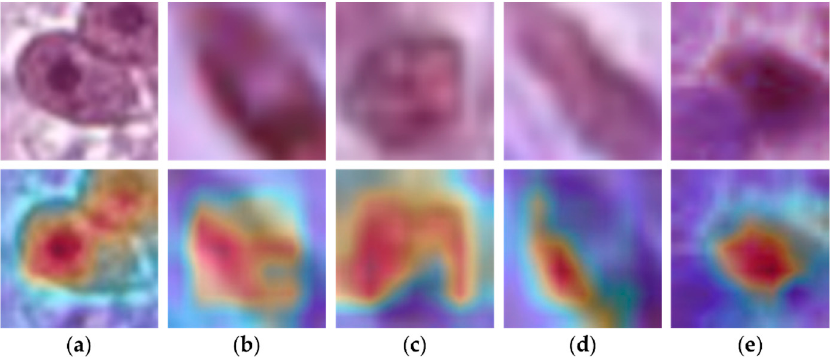
Figure 9. Different types of cell instances in PanNuke (the first row) with their classification saliency maps (the second row). ( a ) neoplastic cell, ( b ) epithelial cell, ( c ) inflammatory cell, ( d ) connective cell and ( e ) dead cell.